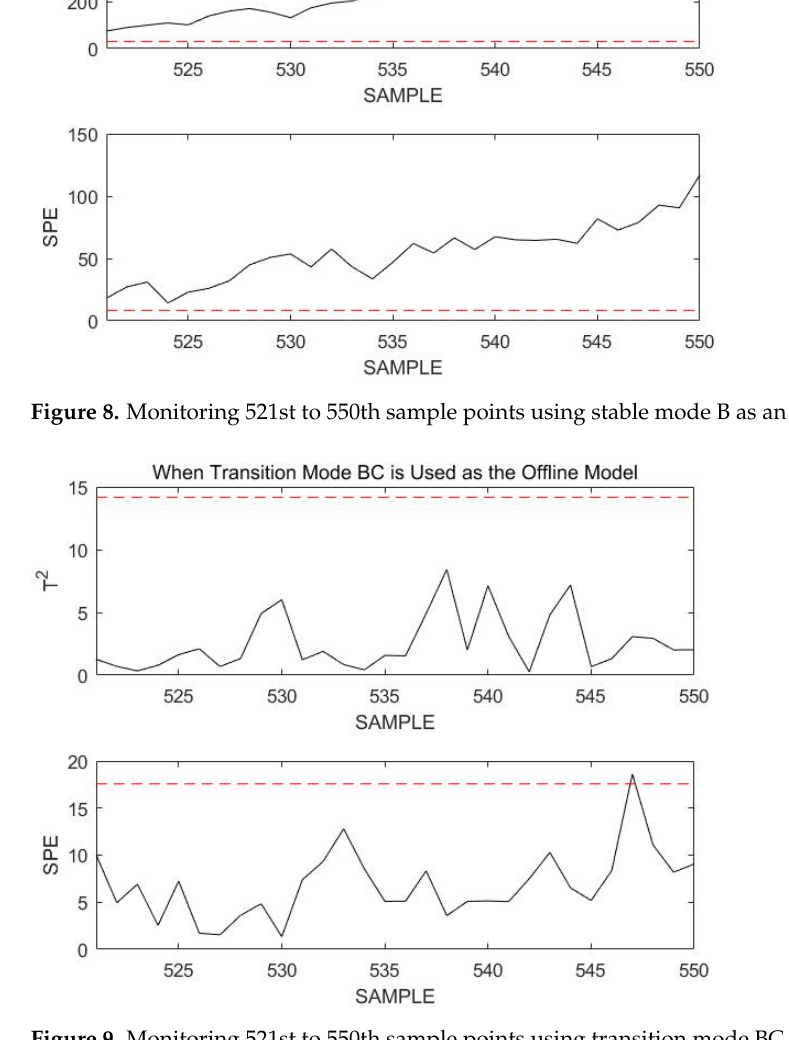
Figure 10. The change curve of D Feed.